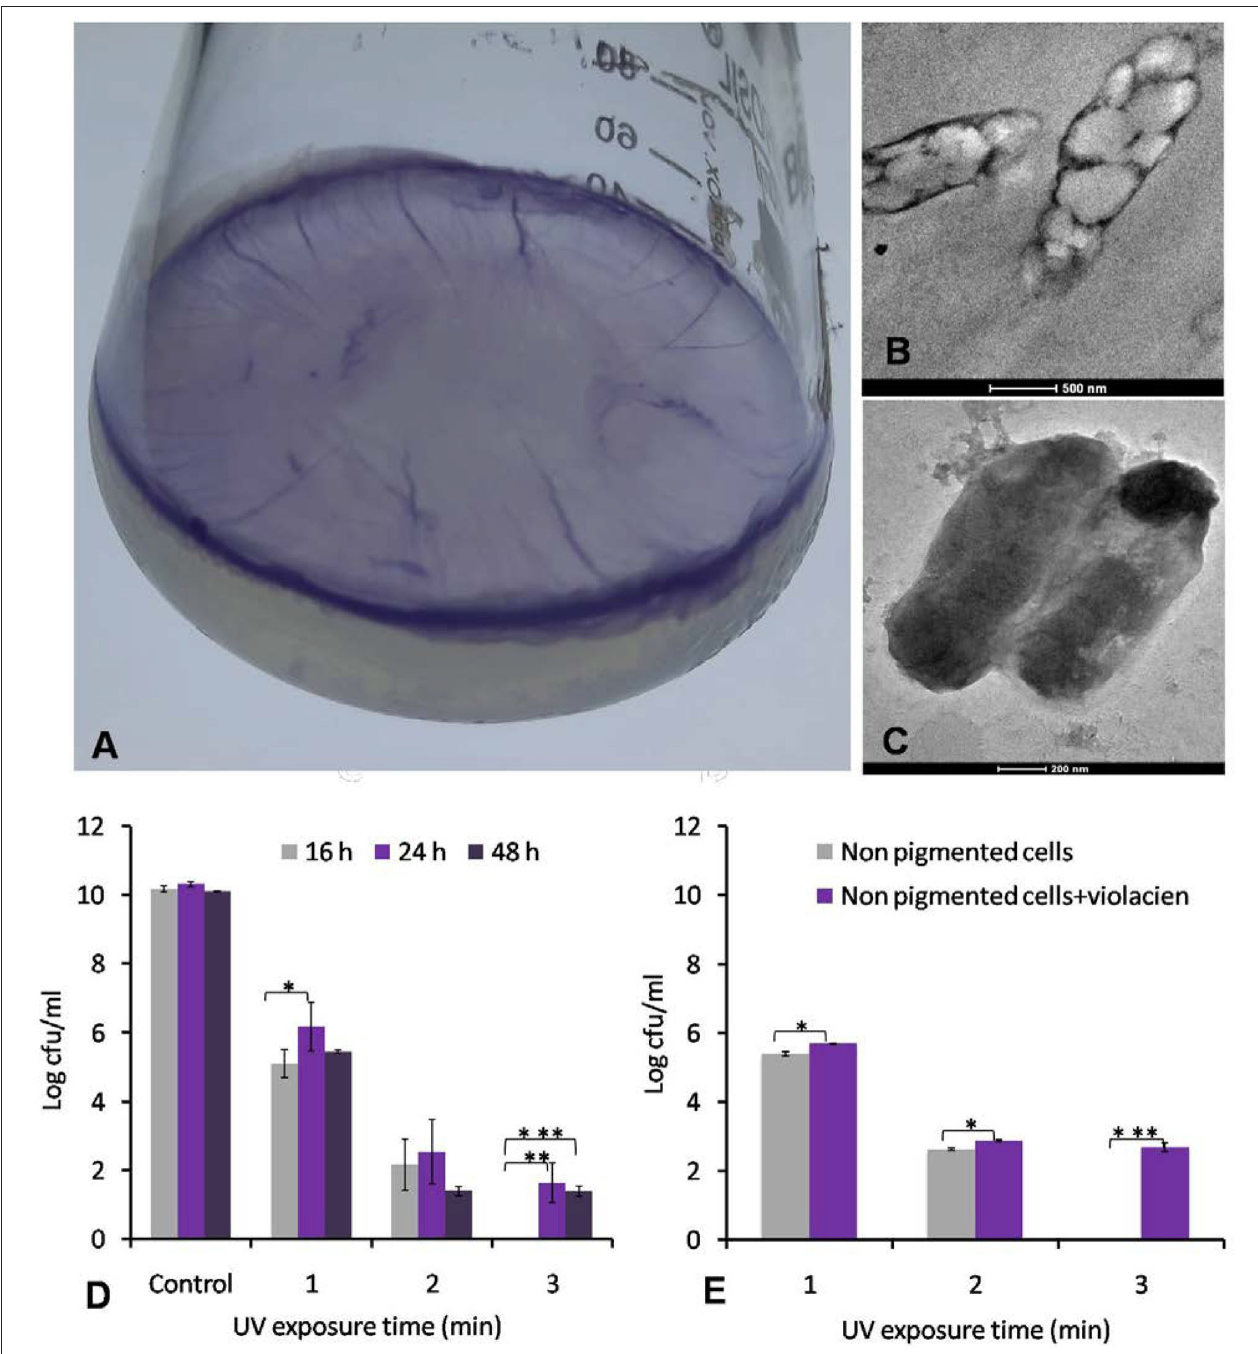
FIGURE 5 | Formation of violate biofilm by Iodobacter sp. PCH194 and UV protective role of violacein pigment. (A) Formation of violet-colored mat on the surface of medium when growing at 4 ◦ C under static conditions, (B) TEM image of ultrathin sections of cells showing the presence of PHA granules, (C) morphology of bacterial cells showing the presence of a sheath around the cell, (D) effect of UV irradiance to cells of Iodobacter sp. PCH194 harvested at different growth phases, viz ., non-pigmented cells of the initial log phase and pigmented cells of exponential log phase and stationary phase (expressing violacein pigment 43–50 and 41–45 µ g/ml/OD 460 ), and (E) effect of violacein (100 µ g/ml) addition to UV tolerance of non-pigmented cells. The level of significance was expressed as a P -value as * ≤ 0.05, ** ≤ 0.01, and *** ≤ 0.001.